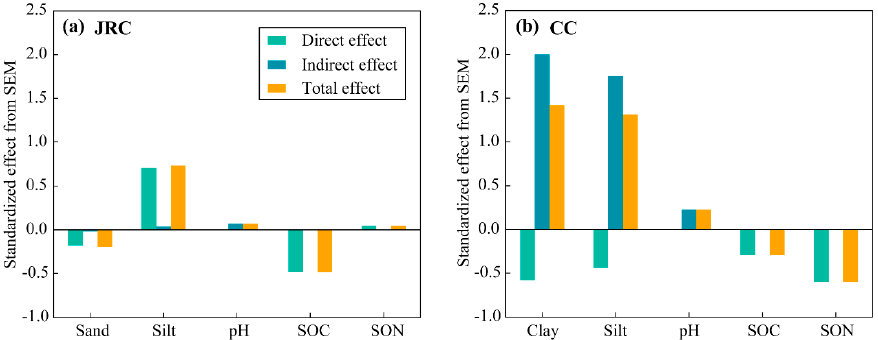
Figure 5. Standardized direct, indirect, and total effects derived from structural equation model (SEM) on the K factor in the JRC ( a ) and in the CC ( b ).